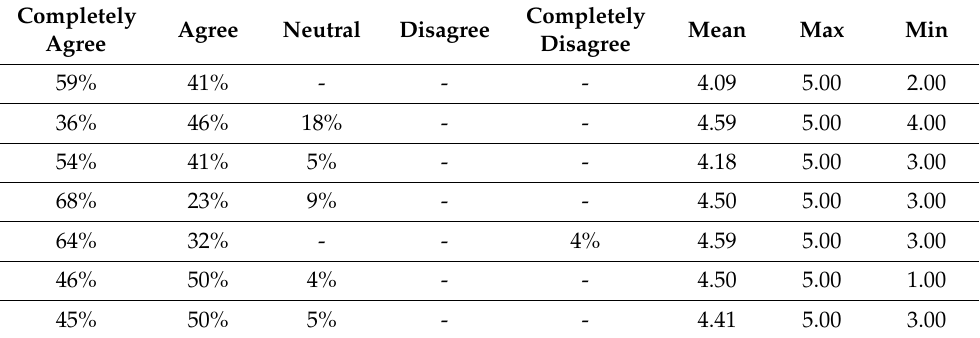
Table 11. The results of the Effectiveness parameter. Completely Agree